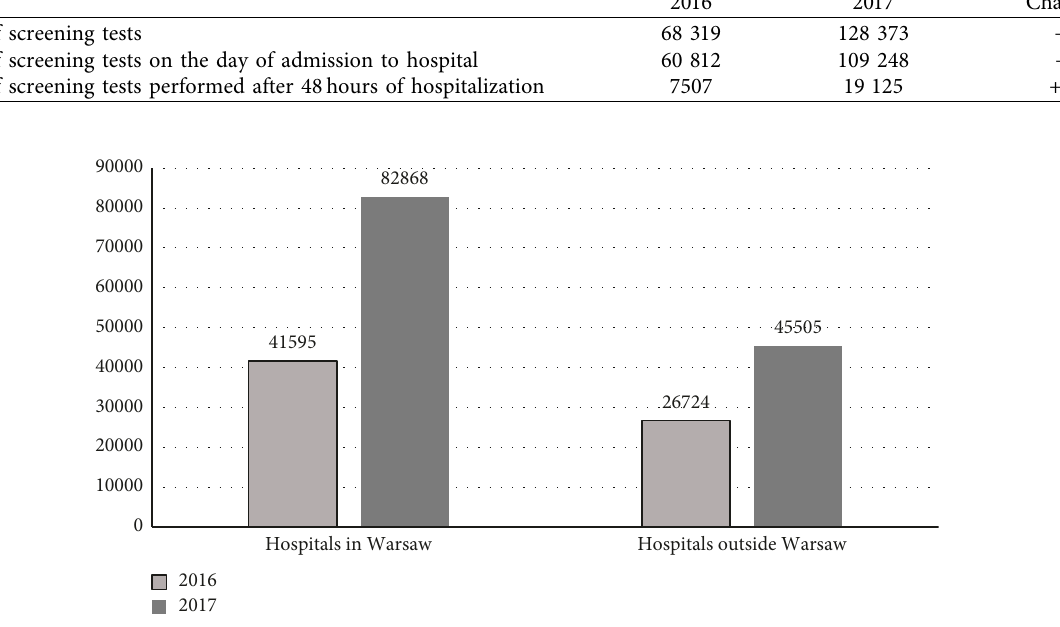
Figure 2: Number of microbiological screening tests performed in hospitals in the Mazovian Voivodeship in